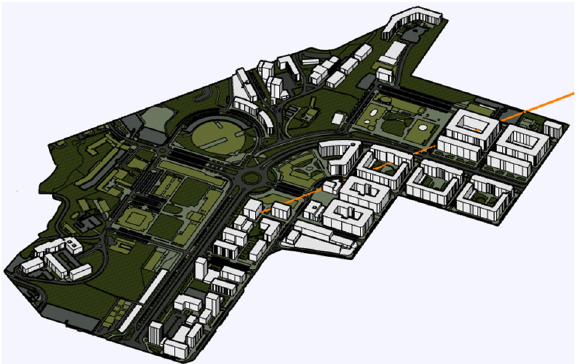
Figure 10. 3D model for the environmental assessment. UPV/EHU DSS campus, phase 1. From the final cloud obtained, accompanied by the merged panoramic image, the data and measurements needed to complete the model were obtained. With these mea- surements the model was generated in NEST-Sketchup and the different reform scenarios were